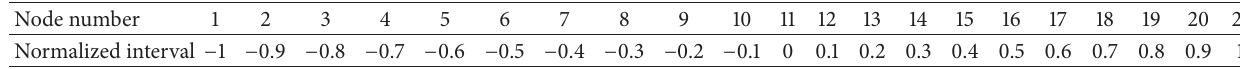
Table 1: Normalized interval for simply supported bridge with 21 nodes.